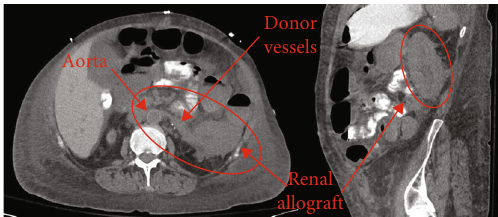
Figure 1: Orthotopic left renal allograft